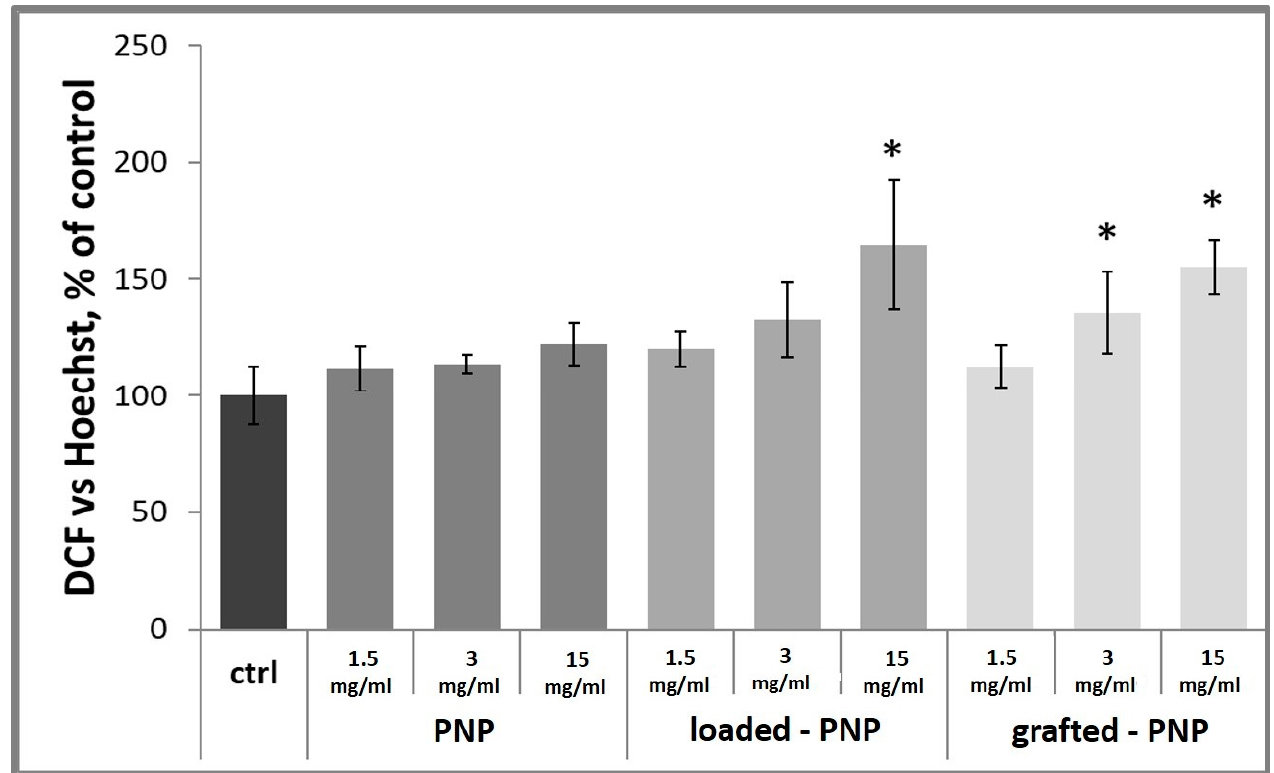
Figure 10. Detection of total ROS production in d-PC12 cells using DCF. Cells were treated 24 h with NPs and then analyzed by a Varioscan multimode microplate reader. Results are represented as the increase in DCF, normalized with live-cell fluorescent staining of DNA Hoechst33342, with respect to untreated control cells. Results are presented as mean ± SD. (* p < 0.05 versus PEG–PLGA NP-3, one-way ANOVA).